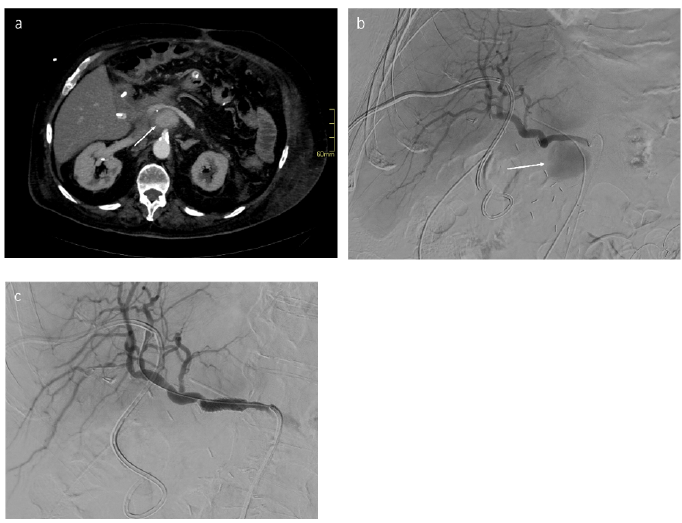
Figure 6. Bleeding pseudoaneurysm of the gastroduodenal artery stump. ( a ) Contrast-enhanced CT in arterial phase following pancreaticoduodenectomy shows a bleeding pseudoaneurysm of the gastroduodenal artery stump (arrow). ( b ) DSA confirms a bleeding pseudoaneurysm of the gastro- duodenal artery stump (arrow). ( c ) After stent–graft placement, DSA shows a total pseudoaneurysm exclusion with regular patency of the stent and of the hepatic